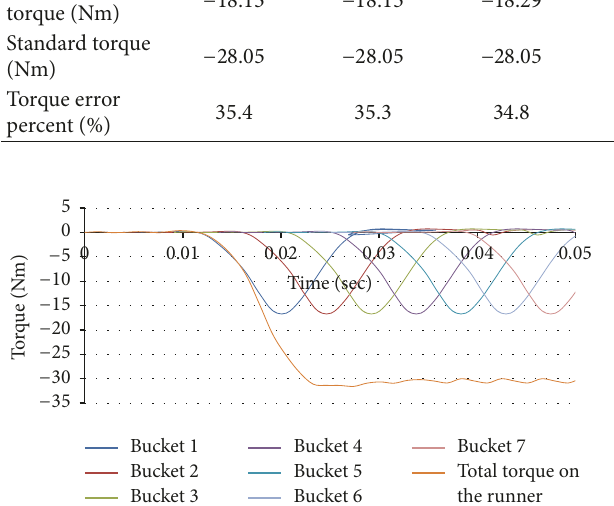
Figure 17: Dynamic runner and bucket torque over time for (PCD = 500 mm).